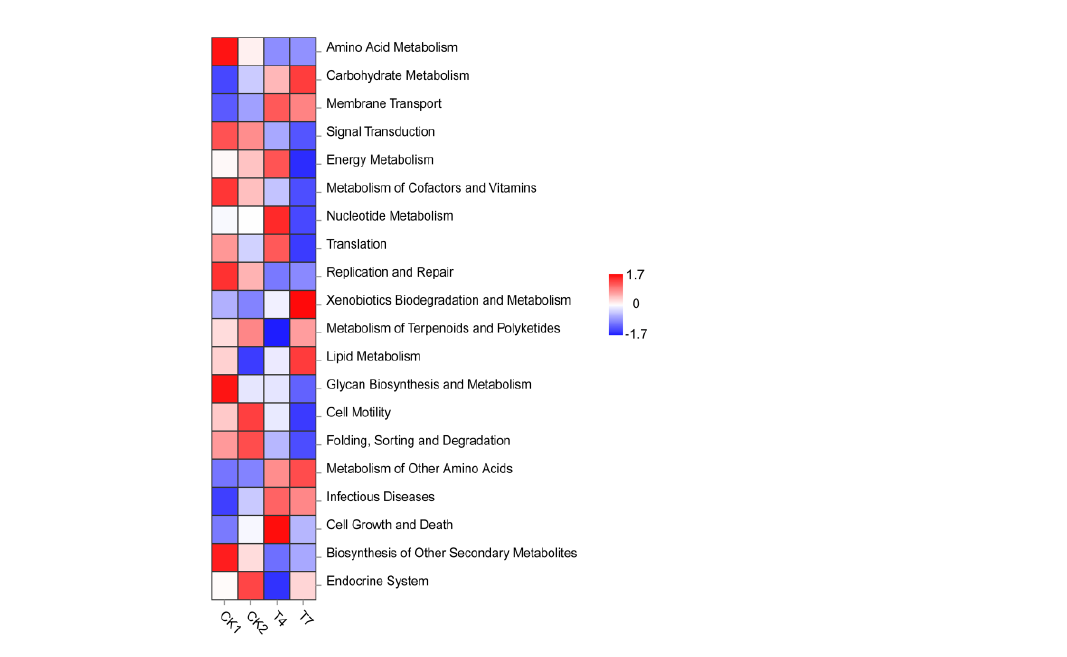
Figure 6. A heat map for predicting the functional contribution of bacteria in soils with different treatments based on Tax4Fun (Functional Category 2). (Colors from blue to red represent the relative abundance of the functions from low to high).